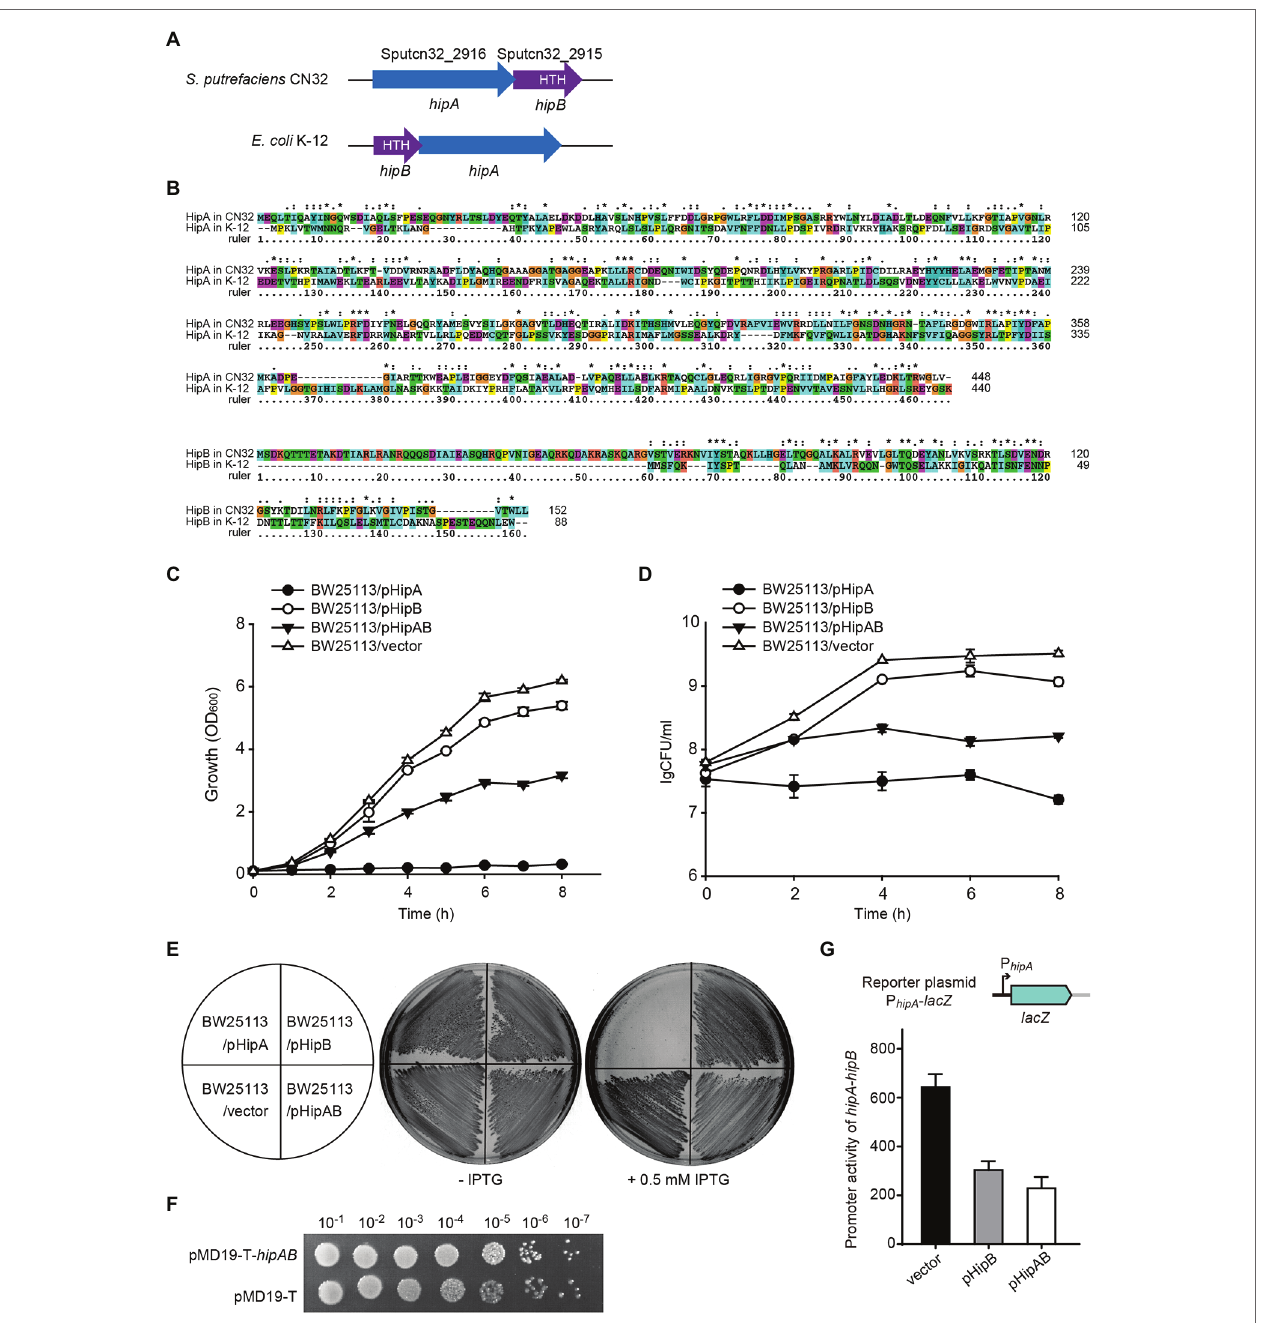
FIGURE 4 | HipA and HipB in GI21 constitute a Toxin–antitoxin (TA) pair. (A) Comparison of the hipA-hipB operon in GI21 and hipB-hipA operon in E. coli K-12. (B) Sequence alignment was carried out using ClustalX to compare the amino acid sequence identity of HipA/HipB in S. putrefaciens CN32 and E. coli K-12. Cell growth (C) and cell viability (D) of cells overexpressing hipA , hipB , and hipA - hipB via pCA24N-based plasmids in E. coli BW25113. (E) Growth of BW25113 cells overexpressing hipA , hipB , and hipA - hipB via pCA24N-based plasmids on LB plates with and without 0.5 mM isopropyl- β -D-thiogalactopyranoside (IPTG). (F) CFU of strain BW25113 containing pMD19-T- hipAB or empty vector pMD19-T on LB plates with ampicillin. (G) The activity of the hipA-hipB promoter in GI21 was measured by overexpressing hipB or hipA-hipB